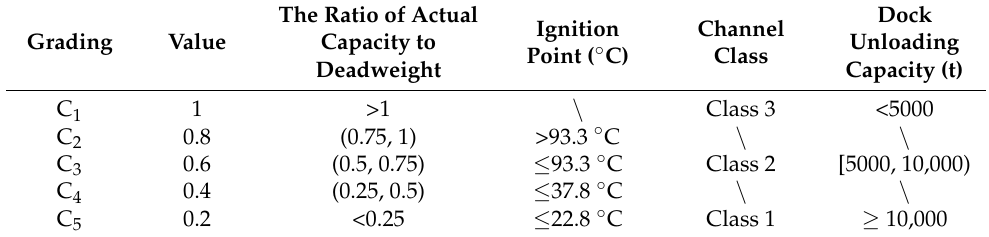
Table 7. Quantitative index grading assignment